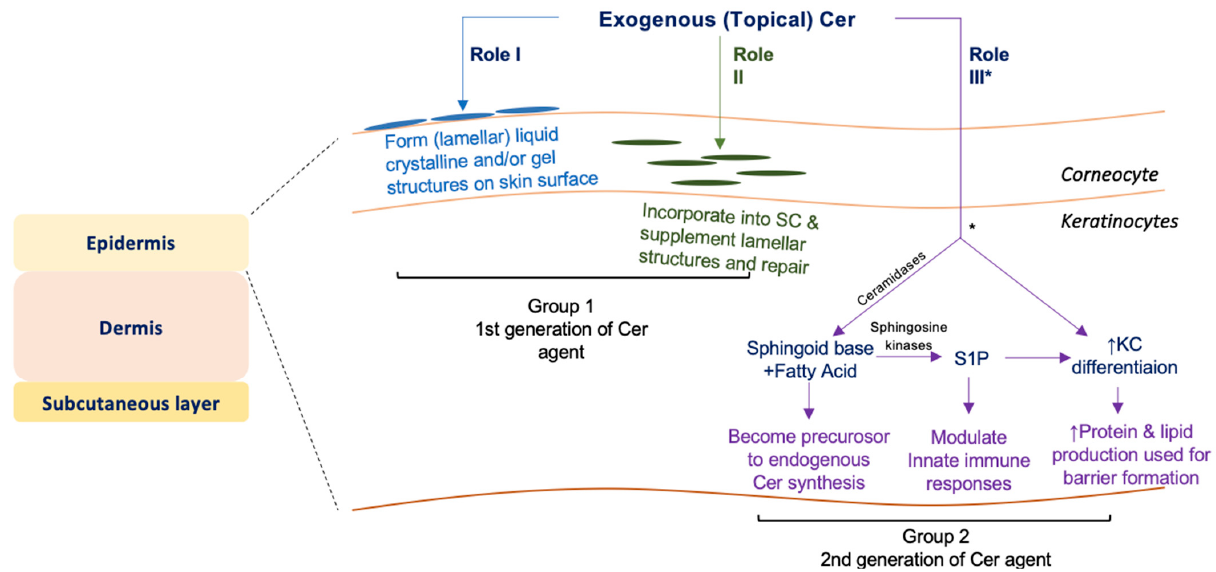
Figure 5. Classification of topical Cer agents.